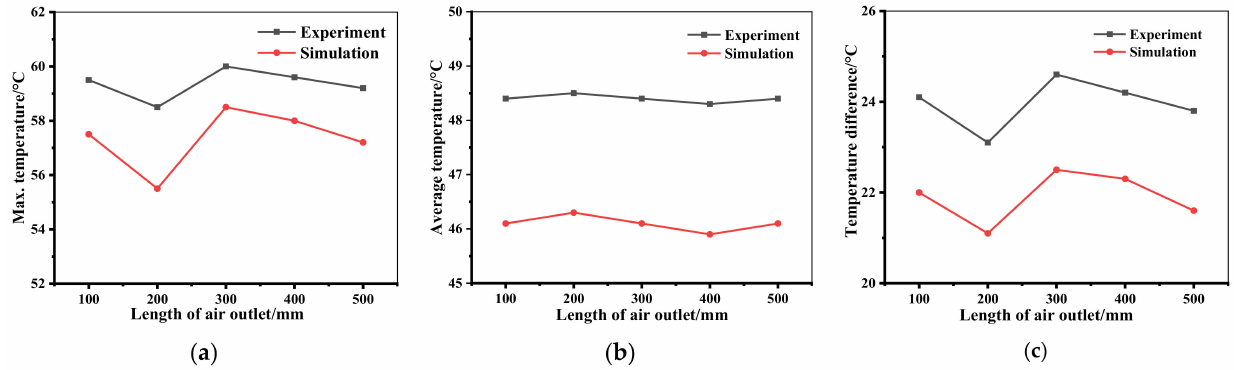
Figure 5. Battery pack temperature change patterns: ( a ) max. temperature ( ◦ C); ( b ) average tempera- ture ( ◦ C); and ( c ) temperature difference ( ◦